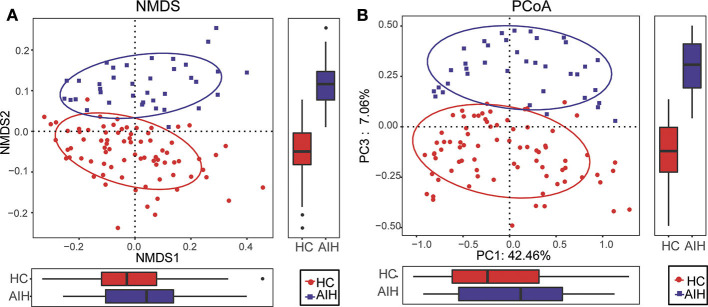
Comparisons of β-diversity in fecal microbiomes of AIH (N = 37) and HCs (N = 78). (A) β-diversity was calculated by NMDS analysis of unweighted UniFrac. Samples of AIH (blue) and HCs (red) groups were distinctly separated in the direction of the NMDS2 axis which means that individuals with AIH were substantially different from healthy individuals. (B) PCoA of unweighted UniFrac PC1-3 showed that the samples of the AIH (blue) and HCs (red) groups were distinctly separated in the direction of the PC3 axis which means that the overall fecal microbiota compositions were markedly different between AIH and HCs. Each symbol represents a sample (blue, AIH; red, HCs). Variance explained by the PCs is indicated by parentheses on the axes. AIH, autoimmune hepatitis; HCs, healthy controls; NMDS, non-metric multidimensional scaling; PCoA, principal coordinate analysis.